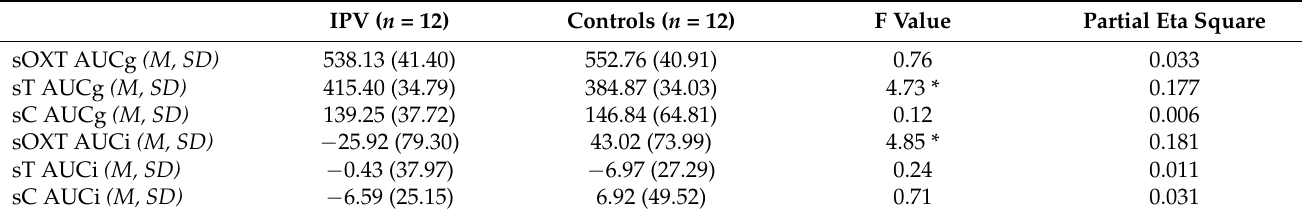
Table 2. Means, standard deviations, percentages, and MANOVA for the hormonal AUCg and AUCi for all